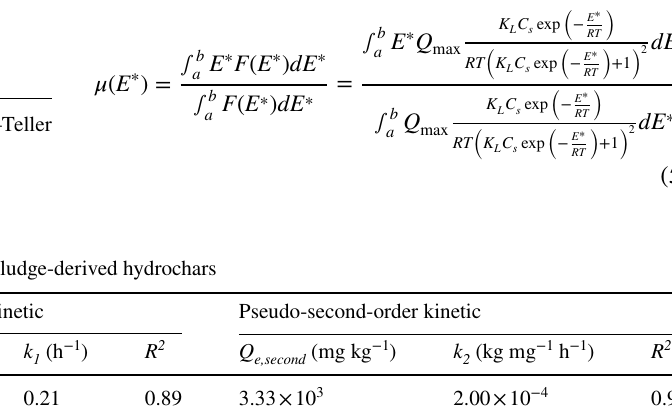
K L is the Langmuir sorption equilibrium constant;